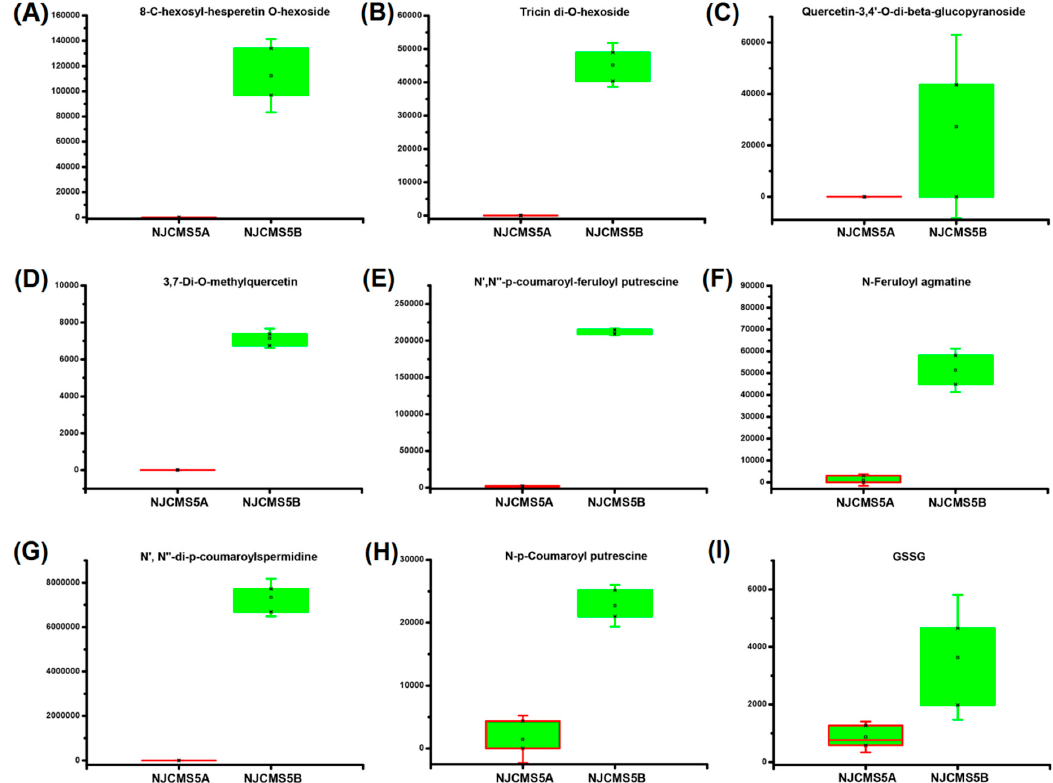
Figure 5. Box plots of differential metabolites involved in non-enzymatic ROS scavenging system of NJCMS5A and NJCMS5B. ( A ) 8-C-hexosyl-hesperetin O -hexoside; ( B ) Tricin di- O -hexoside; ( C ) Quercetin-3,4'- O -di- β -glucopyranoside; ( D ) 3,7-Di- O -methylquercetin; ( E ) N',N"-p-coumaroyl-feruloyl putrescine; ( F ) N -Feruloyl agmatine; ( G ) N ', N ''-di-p-coumaroylspermidine; ( H ) N -p-Coumaroyl putrescine; ( I ) GSSG-Glutathione oxidized.